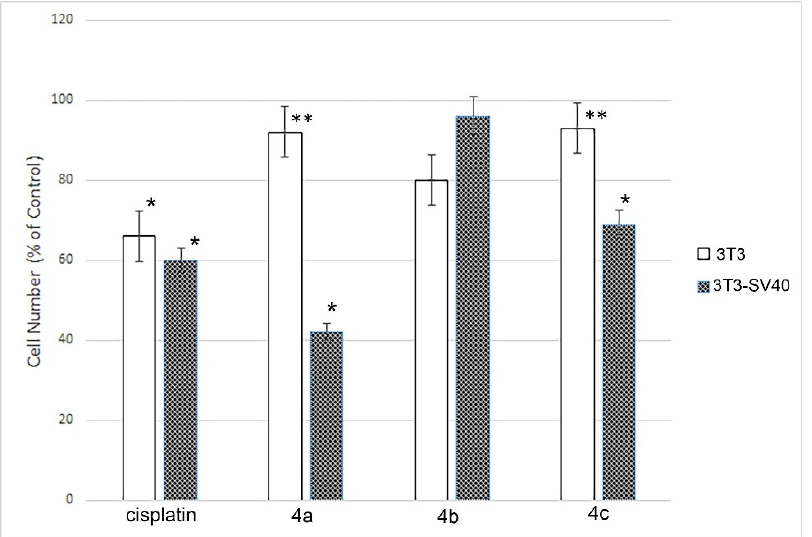
Figure 1. Effect of spiro-fused [3-azabicyclo[3.1.0]hexane]exindoles derivatives 4a-c and cisplatin on growth 3T3 and 3T3 SV40 cells. The graph demonstrates the effect of the compounds on cell growth in relation to the control. Results are averages of 3 replicates in each experiment, given as the mean ± SD values. * p ≤ 0.05. ** intergroup significance levels p ≤ 0.05.